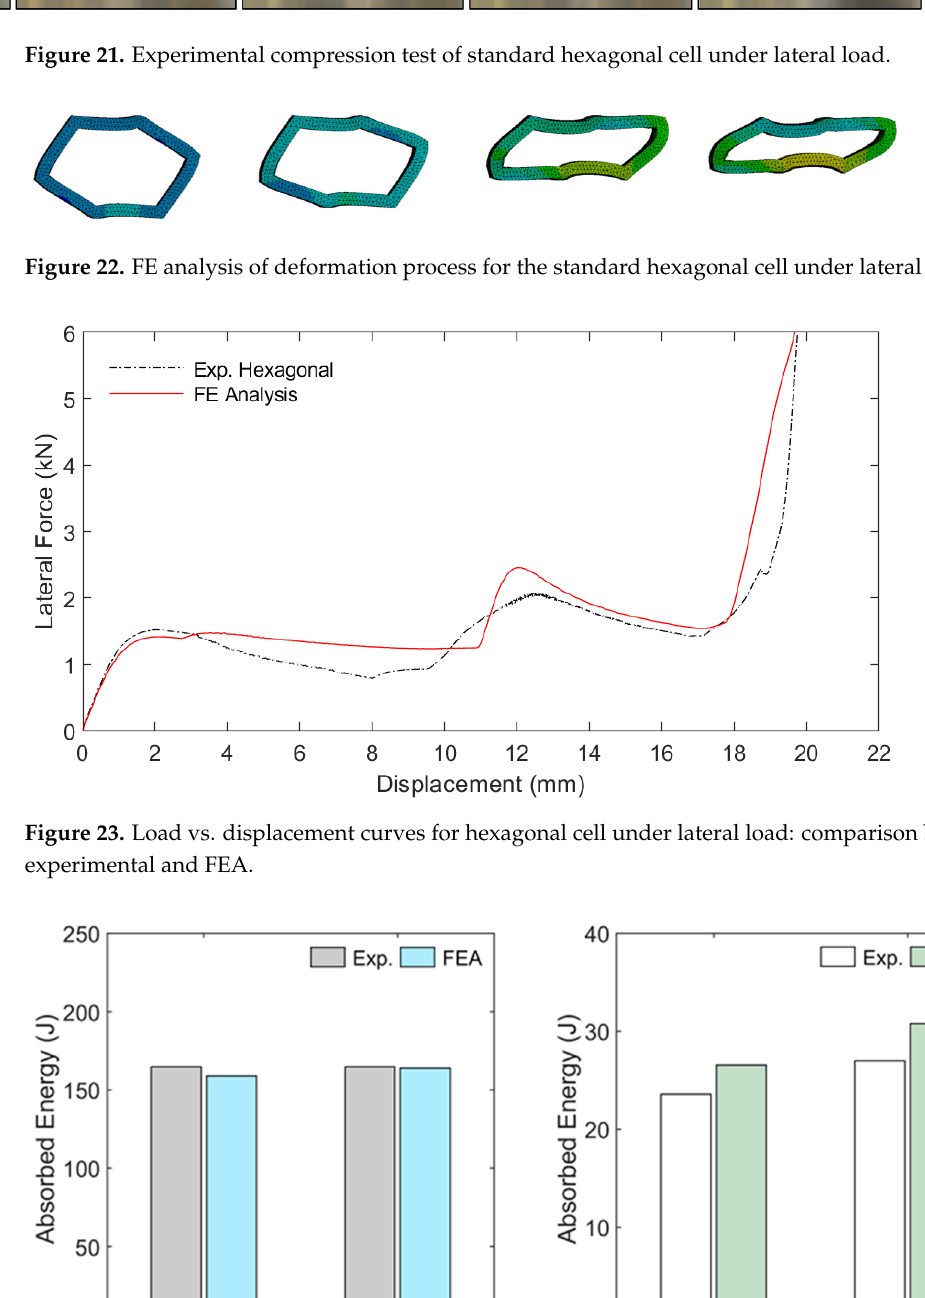
Figure 22. FE analysis of deformation process for the standard hexagonal cell under lateral load.